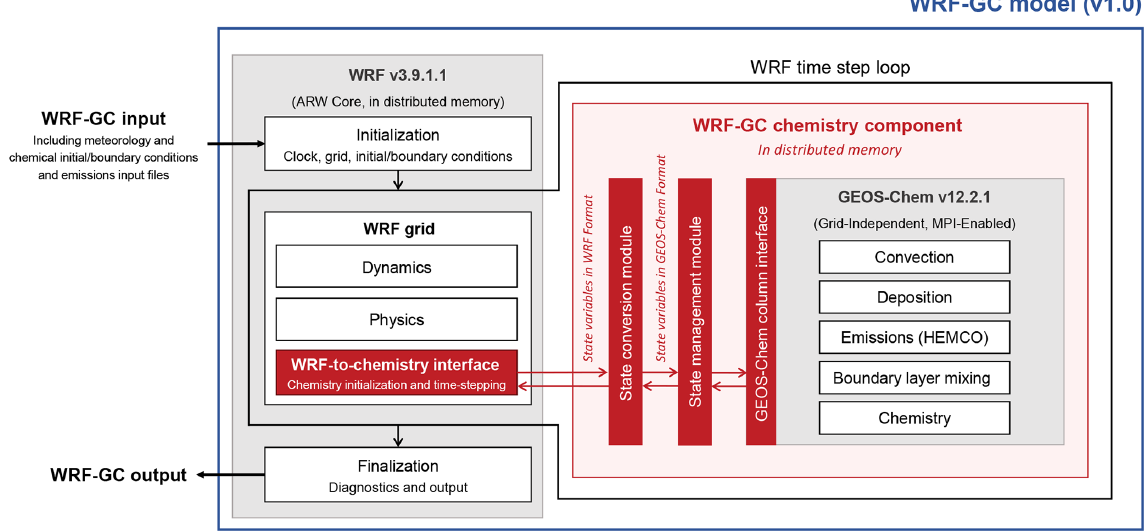
Figure 1. Architectural overview of the WRF-GC model (v1.0). The WRF-GC coupler (all parts shown in red) includes interfaces to the two parent models, as well as the state conversion and state management modules. The parent models (shown in grey) are standard codes downloaded from their sources, without any